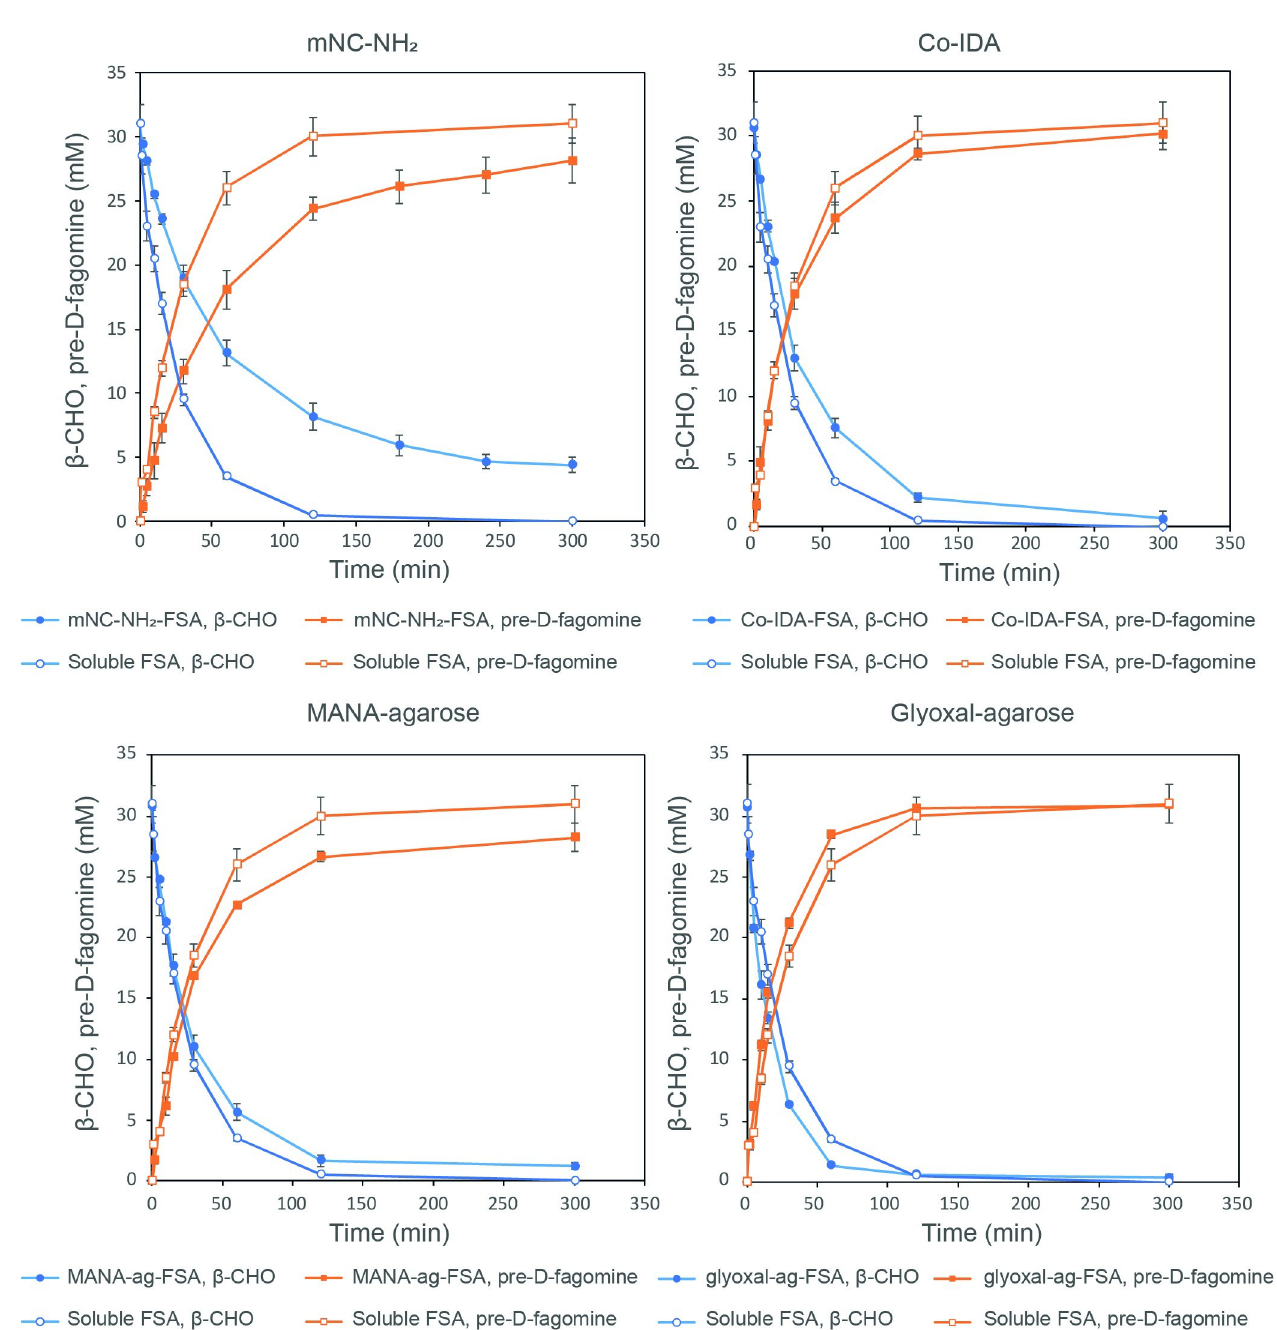
Fig 3. Aldol addition reaction of DHA and β -CHO (•) producing pre-D-fagomine ( ■ ) catalyzed by soluble FSA and FSA immobilized in mNC-NH 2 (A), in Co-IDA (B), in MANA-agarose (C) and in glyoxal-agarose (D). The reaction catalyzed by soluble enzyme is represented with the dashed line in all the reaction plots. The reaction medium contained: 45 mM DHA, 30 mM β -CHO and 1 U mL -1 of reaction. The aldol addition was performed at 25˚C and pH 8.0 and 10 mL total reaction volume (1 mL reaction volume for the mNC-NH 2 derivative).